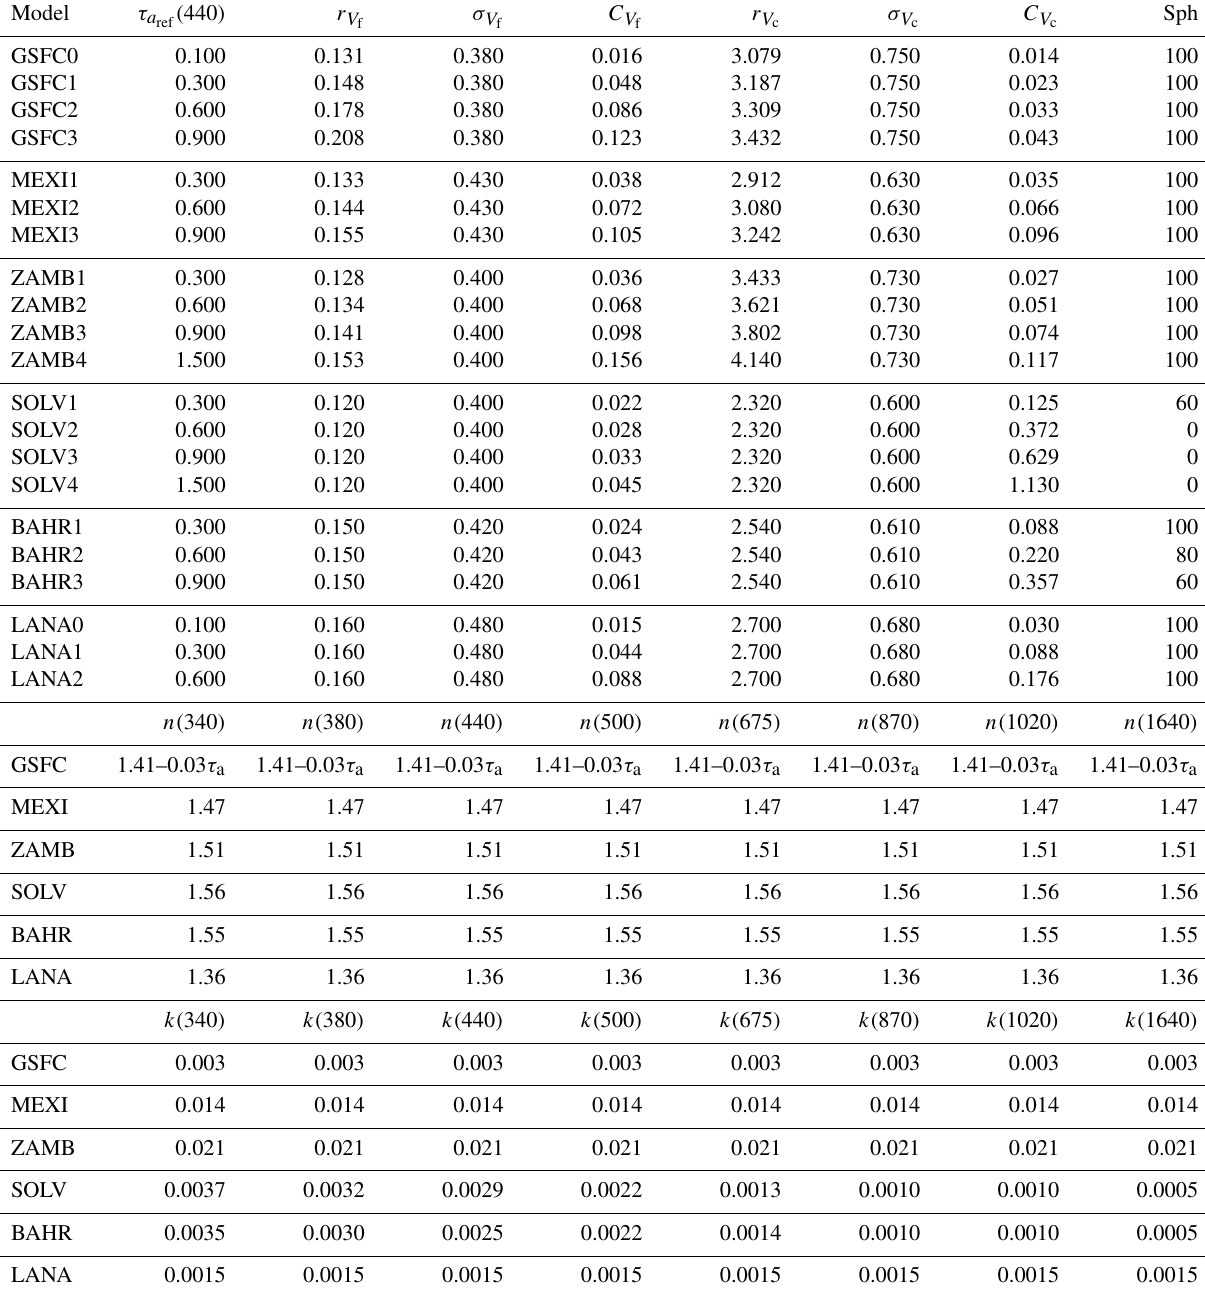
Table 1. Description of aerosol properties used for simulating the aerosol optical depth measurements. They are based on the climatology study of Dubovik et al. (2002a). The first part of the table specifies the parameters describing the aerosol load, the size distribution (modelled as a bimodal log-normal function: r V [µm], σ V and C V [µm 3 µm − 2 ]) and the sphericity parameter (Sph). The second part of the table i i i contains the refractive index ( n(λ) and k(λ) ) inputs for each aerosol model. Note that the values of the refractive index are constant for all the aerosol examples regardless of the aerosol load, except for the case GSFC in which they depend on the aerosol optical depth at 440nm represented as τ a